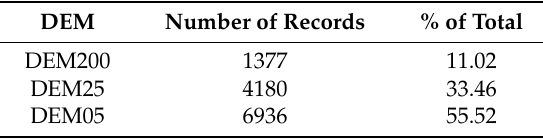
Table 3. Data concerning the type of DEM